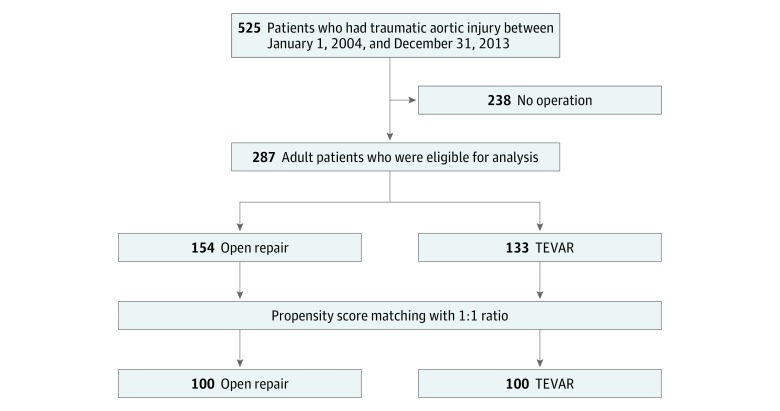
Enrollment of the Study PatientsTEVAR indicates thoracic endovascular aortic repair.